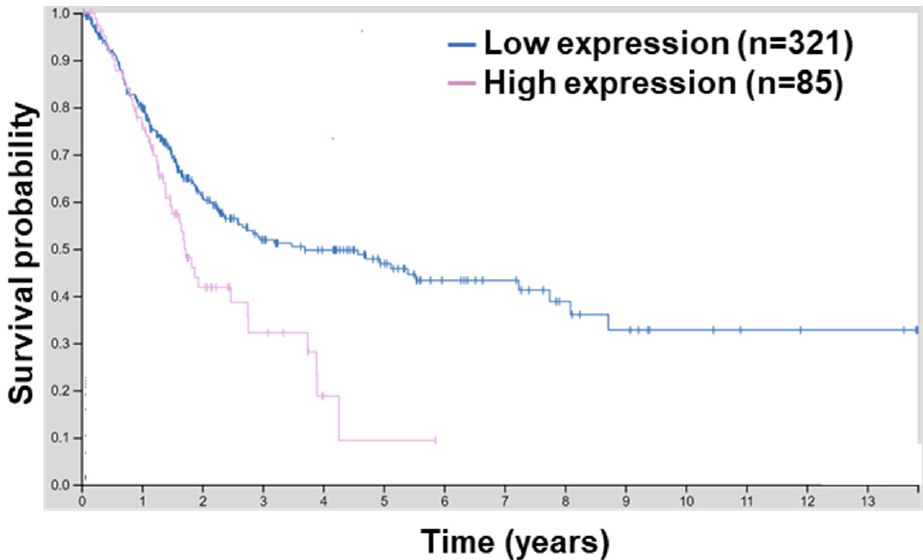
Figure 1. BCL9L expression is associated with worse survival probability. Survival analyses by the human protein atlas using TCGA data of 406 MIBC results in a significant correlation between high BCL9L expression and worse survival probability (expression cut-off 7.44 fragments per kilobase of transcript per million; log-rank p = 0.0029; http://www.proteinatlas.org/ENSG00000186174-BCL9L/ pathology/urothelial+cancer) (accessed on 27 March 2022)